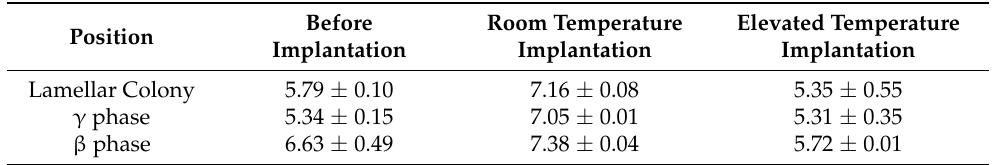
Table 1. The nanohardness of as-cast alloy at different positions before and after ion implantation (GPa).